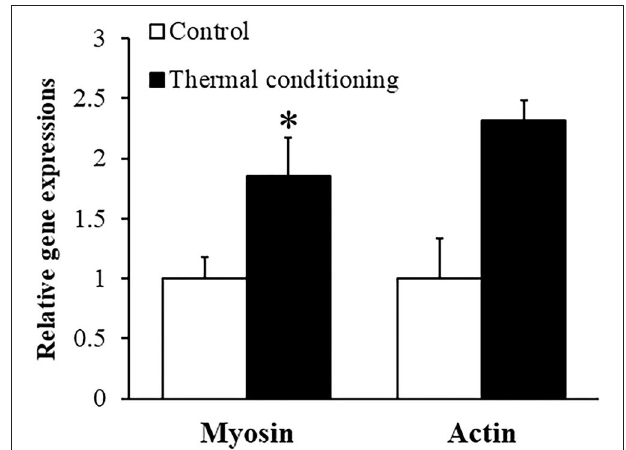
FIGURE 3 | Effect of thermal conditioning on gene expression in pectoral muscle in chicks. Asterisks refer to the level of statistical significance (* P < 0.05). Data were expressed as means ± SEM. The number of chickens in each group was n = 7–8.